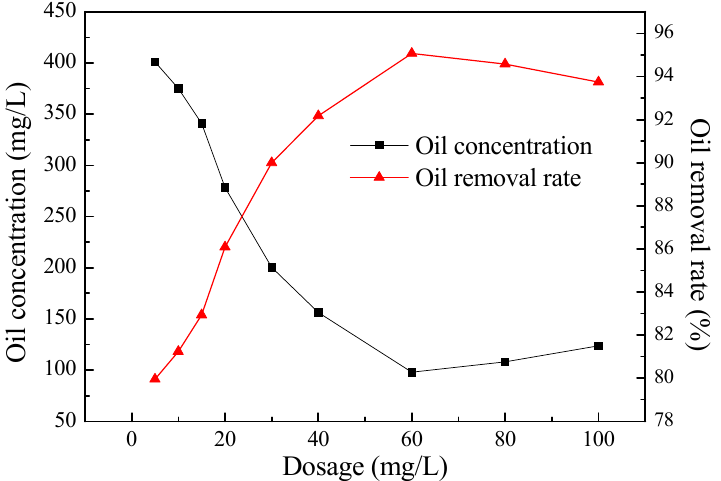
Figure 6. E ff ect of the dosage of flocculant on oil concentration and oil removal Figure 6. Effect of the dosage of flocculant on oil concentration and oil removal rate.